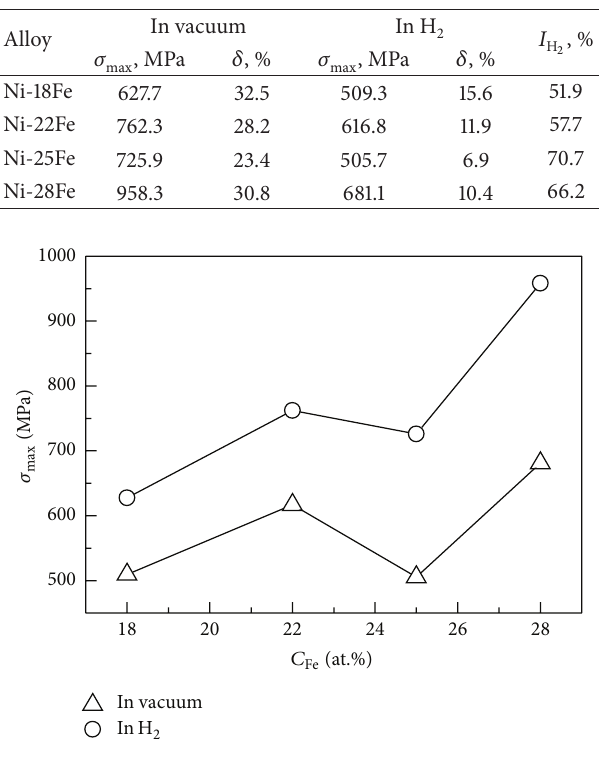
Fe alloy with 3 . 2